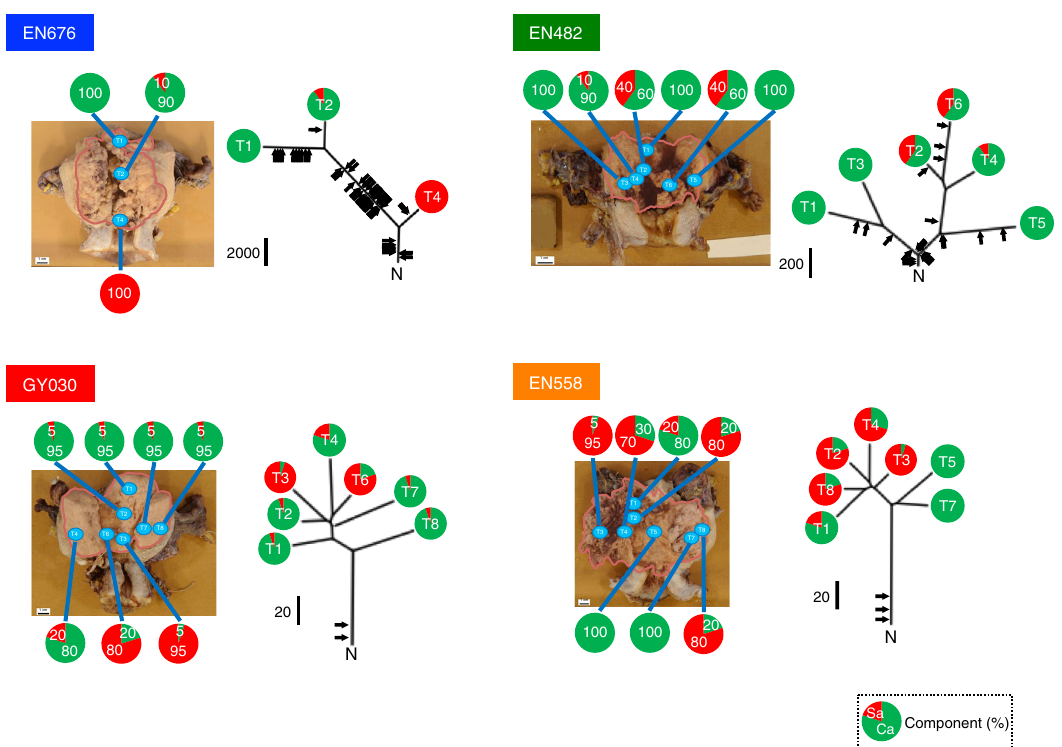
Fig. 6 Phylogenetic tree analyses with SNVs and indels from the multi-regional exome-sequenced samples of uterine CSs. We selected representative tumors that were completely resected during surgery for each genomic aberration subtype (blue, POLE; green, MSI; red, CNH; and orange, CNL) and rendered to multi- regional exome sequencing. The phylogenetic tree (right) is presented alongside the entire tumor (left) with the margin shown as a pink line. The positions of sample collection are shown. Trunk/branch length is proportional to the total number of SNVs and indels. An index black bar beside the trunk indicates the number of base-pair mutations. The timing of driver mutation acquisition is shown with an arrow. Ca, carcinoma; Sa, sarcoma. The proportions of carcinoma and sarcoma components in each CS sample are shown as a pie chart, with green and red colors indicating the proportion of each